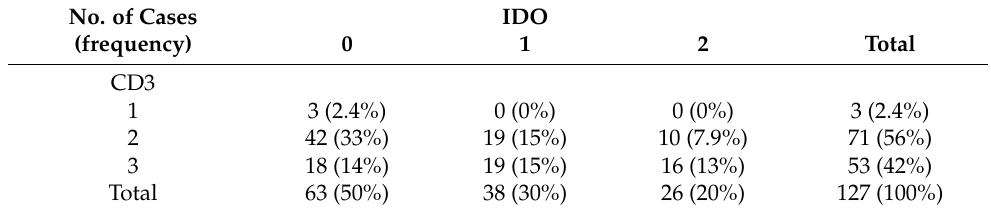
Table 6. Contingency table of CD3 versus IDO.